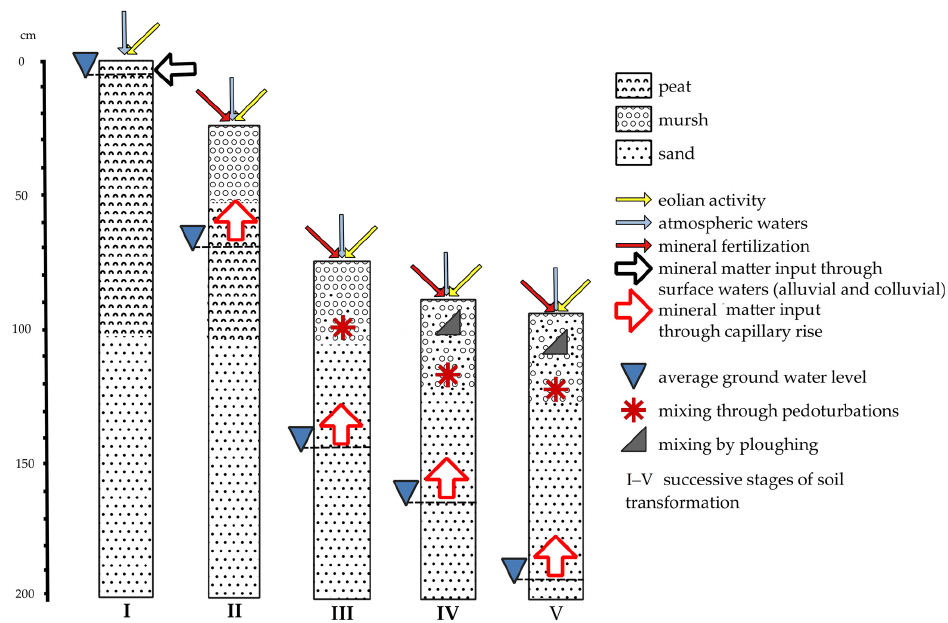
Figure 3. Successive stages of organic soil transformation showing the inflow of mineral matter to soil; ( I ) — PSC (2019): Hemic peat soil (Gleba torfowa hemowa), WRB (2022): Rheic Hemic Histosol; ( II ) — PSC (2019): Hemic murshic soil (Gleba murszowa hemowa), WRB (2022): Murshic Hemic Histosol; ( III ) — PSC (2019): Thin murshic soil (Gleba murszowa p ł ytka), WRB (2022): Histic Gleysol (Arenic, Drainic, Mulmic); ( IV ) — PSC (2019): Typical semimurshic soil (Gleba murszowata typowa), WRB (2022): Mollic Gleysol (Arenic, Drainic, Mulmic); ( V ) — PSC (2019): Postmurshic soil (Gleba murszasta), WRB (2022): Umbric Gleysol (Arenic, Drainic, Humic, Nechic).